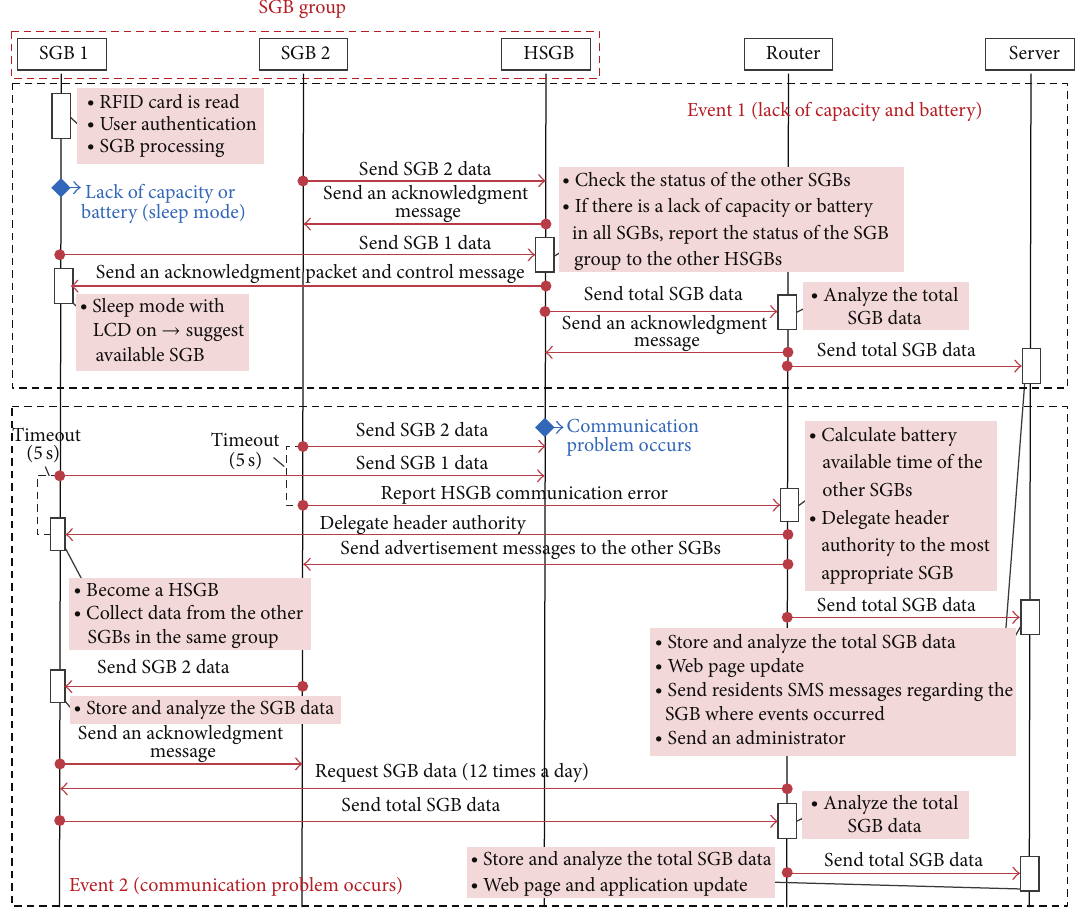
Figure 8: Sequence diagram for operation of the smart garbage system for two different events.